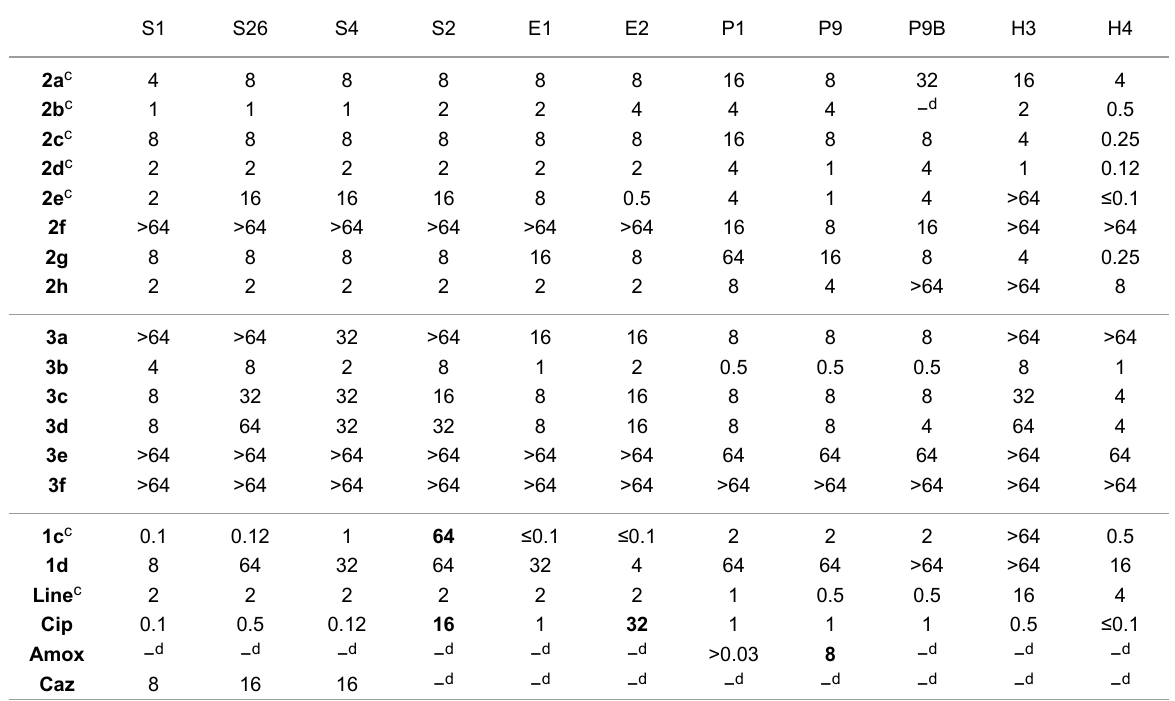
Table 2: In vitro antibiotic activity (MIC, µg/mL) of tetramic acids.